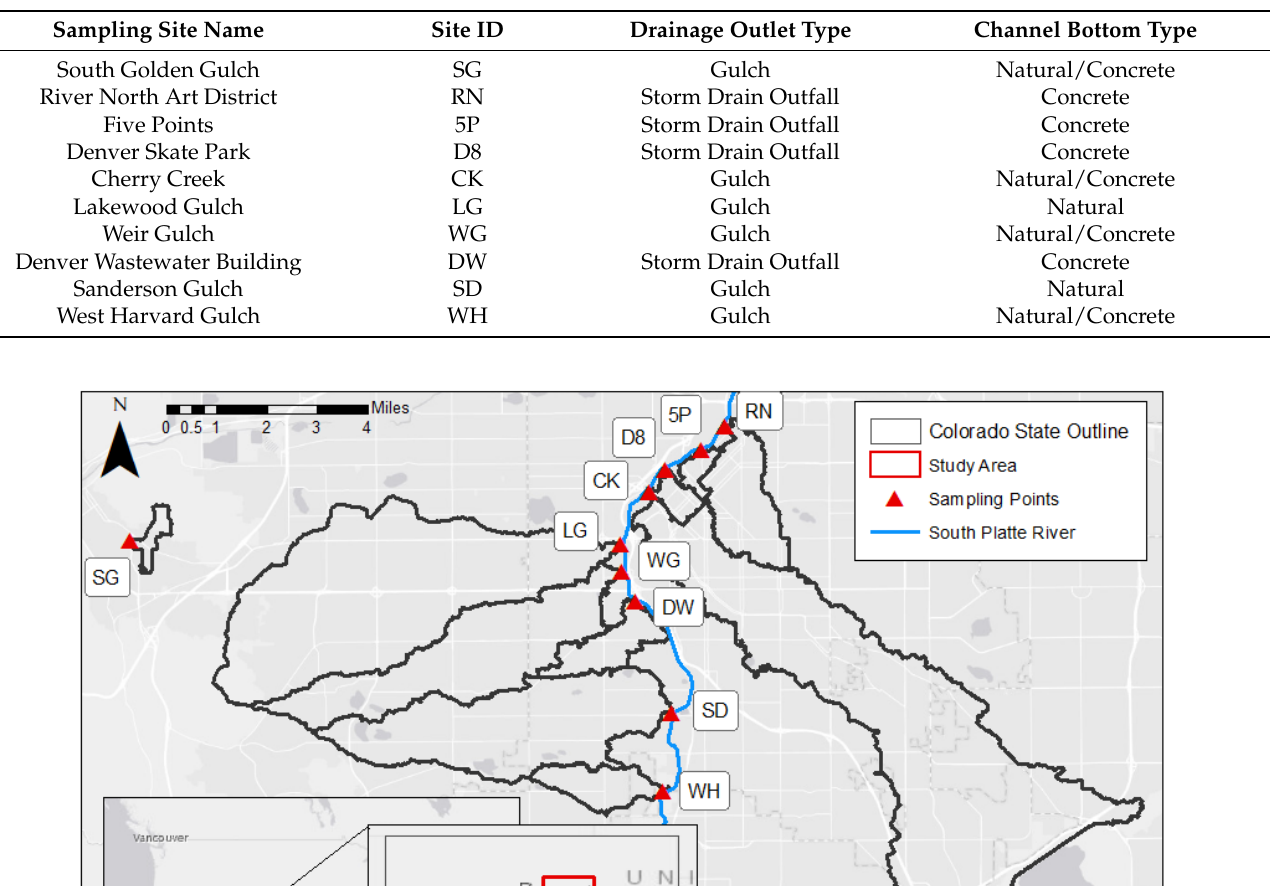
Table 1. Basic sampling site descriptions.